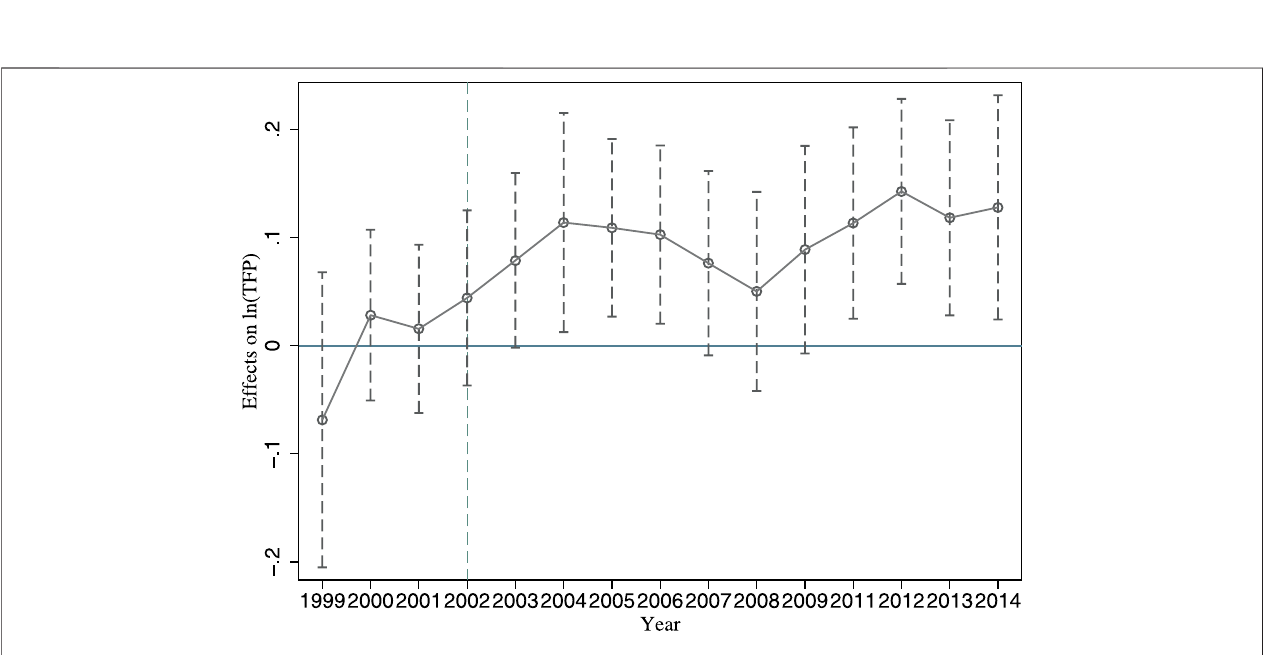
FIGURE 2 | Parallel trend test of SO 2 emissions.